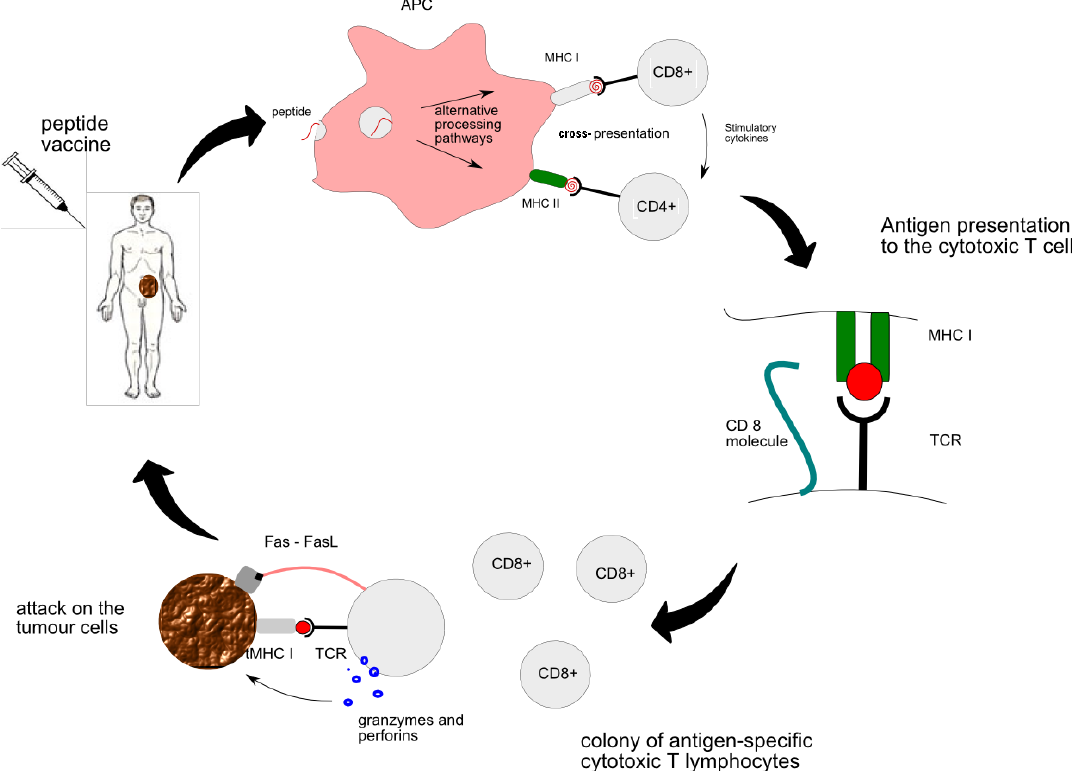
Figure 1. The mechanism of anti-tumour effect of peptide vaccine therapy: introduction of vaccine to the bloodstream; processing and presentation of the peptide by the antigen-presenting cell (APC) in a lymph node resulting in activation of CD4+ helper T cells and CD8+ cytotoxic T cells; interaction between MHC I molecule on APC and T cell receptor (TCR) during antigen presentation facilitated by CD8 molecule; generation of tumour-specific CTLs capable of lysing tumour cells: degranulation of CTL following recognition of tumour antigen and Fas-mediated transduction of death signal to the